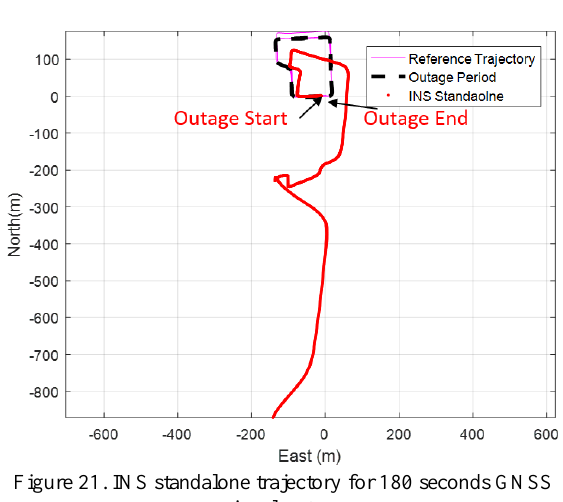
Figure 18. Modified 3D RISS trajectory for 90 seconds GNSS signal outage